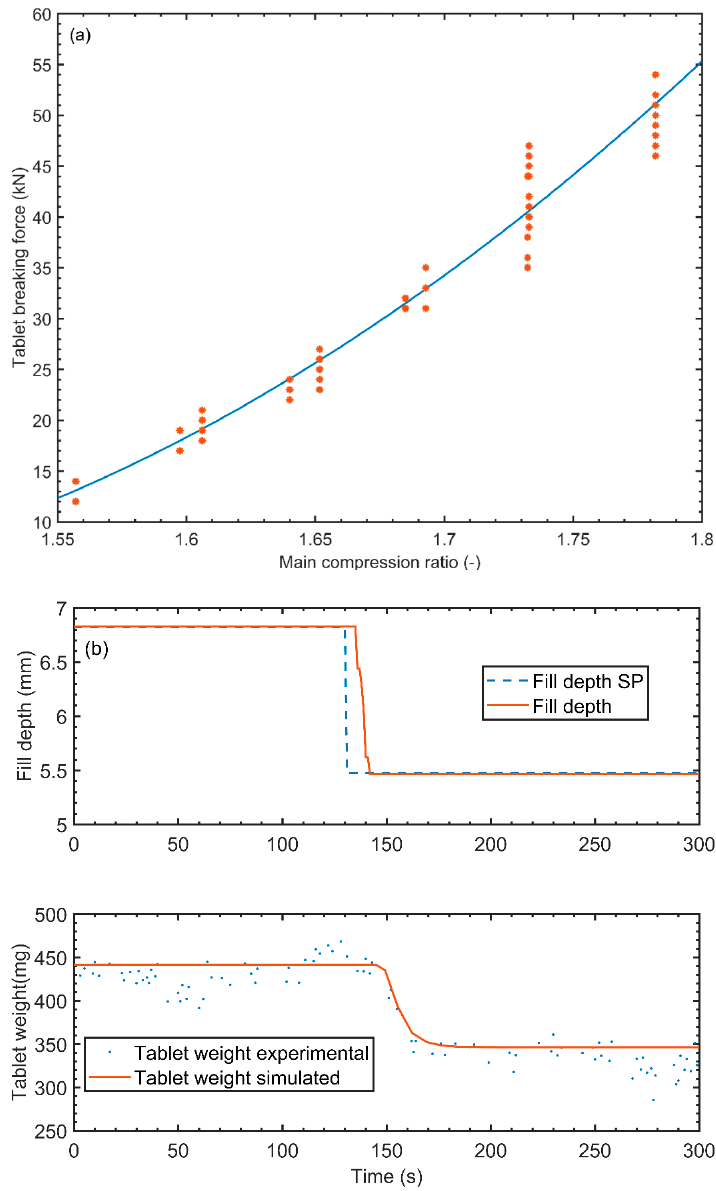
Figure 7. ( a ) Tablet breaking force model validation ( b ) Tablet weight model validation.